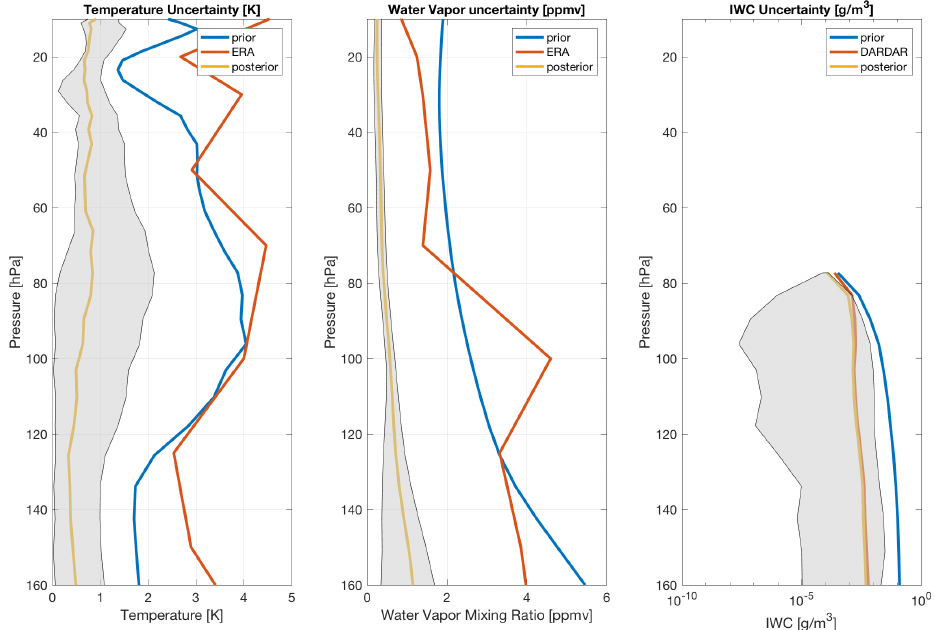
Figure A2. Uncertainties in temperature, water vapor mixing ratio, and IWC, estimated from the average of 2735 retrieved profiles with various cloud-top heights. Blue, orange, and yellow curves show uncertainties in the prior ( S a ), the ERA5 ( S model ), and the posterior ( S post ), respectively. The grey-shaded area is the range of posterior uncertainties.